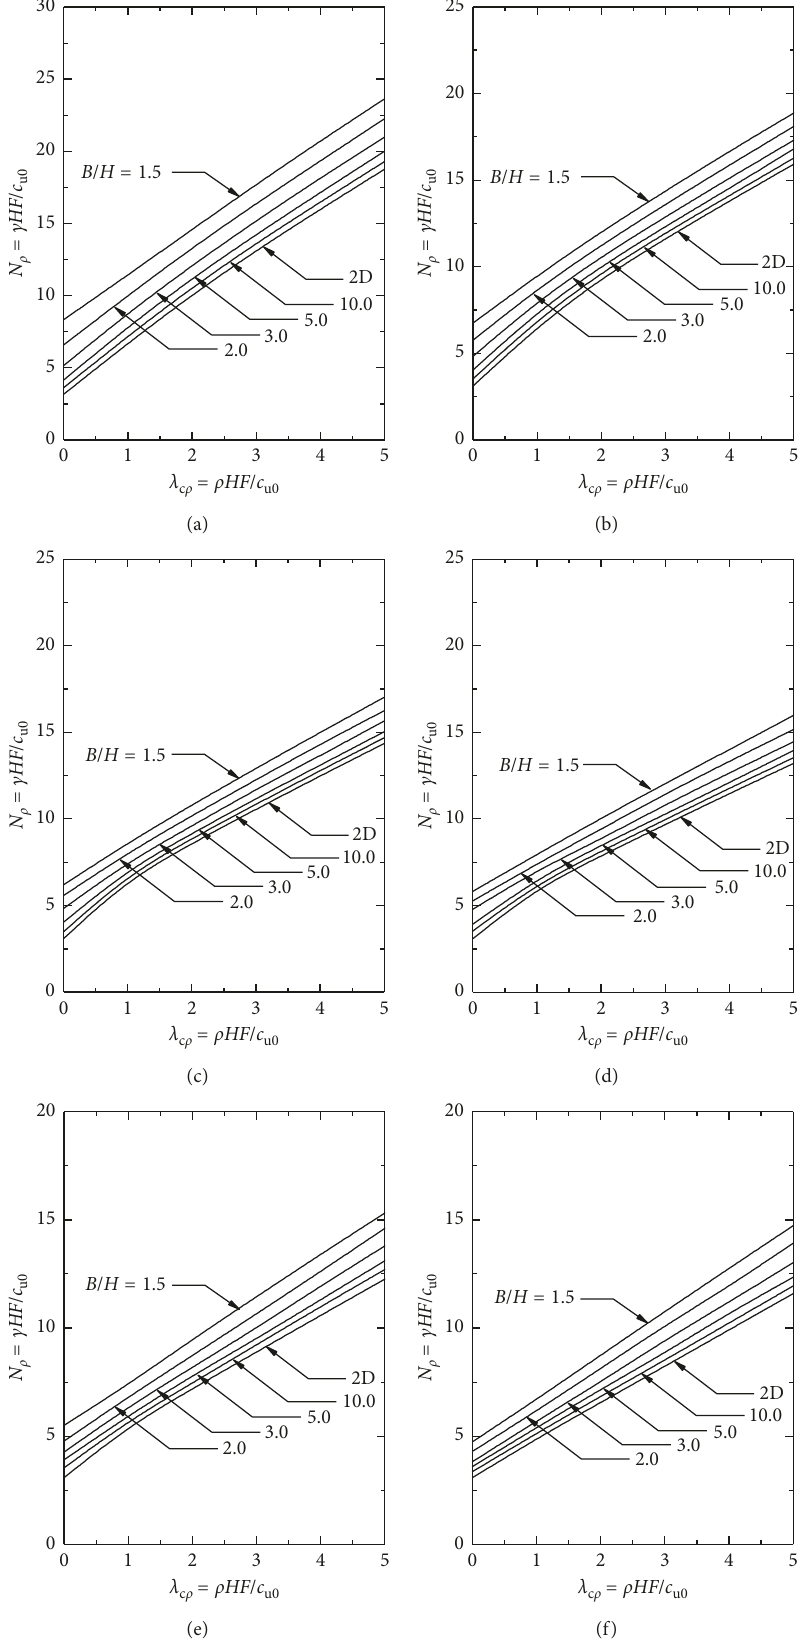
Figure 11: Seismic stability charts for natural slopes with k h (cid:31) 0.2. (a) β (cid:31) 15 ° . (b) β (cid:31) 30 ° . (c) β (cid:31) 45 ° . (d) β (cid:31) 60 ° . (e) β (cid:31) 75 ° . (f) β (cid:31) 90 °